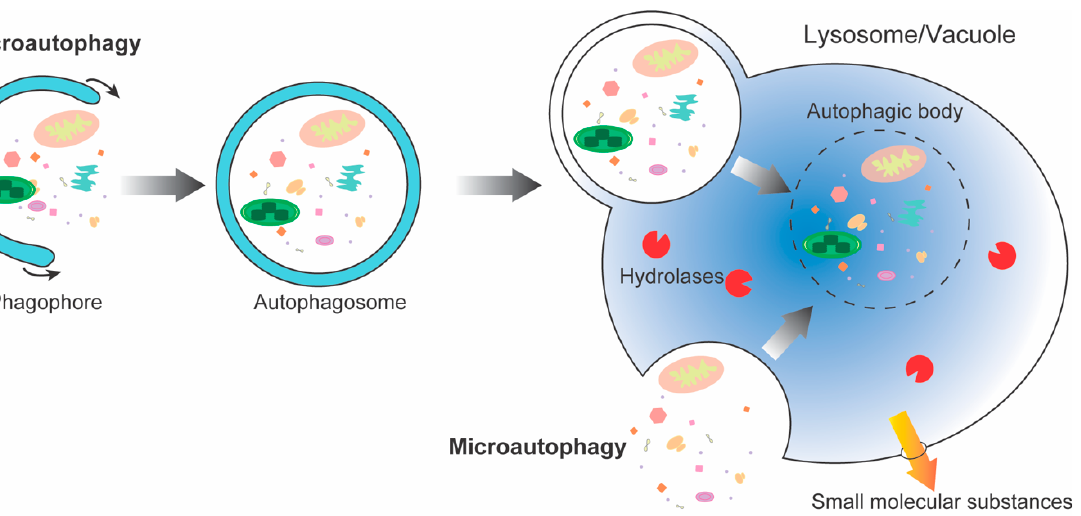
Figure 1. Morphological steps of microautophagy and macroautophagy in eukaryotes. Macroautophagy begins with the formation of a phagophore that encapsulates damaged organelles and discarded proteins. Then, through the extension of the vesicle forms a closed structure with a double membrane, which is called an autophagosome. Subsequently, the outer membrane of the autophagosome fuses with the lysosomal membrane (animals) or the tonoplast (yeast and plants) to release the autophagic body with only a single membrane. Finally, under the digestion of acid hydrolases, the cargoes were degraded into small molecular substances for recycling. Microautophagy is a process in which the lysosome/vacuole directly packages target substrates by membrane invagination to create the autophagic body.